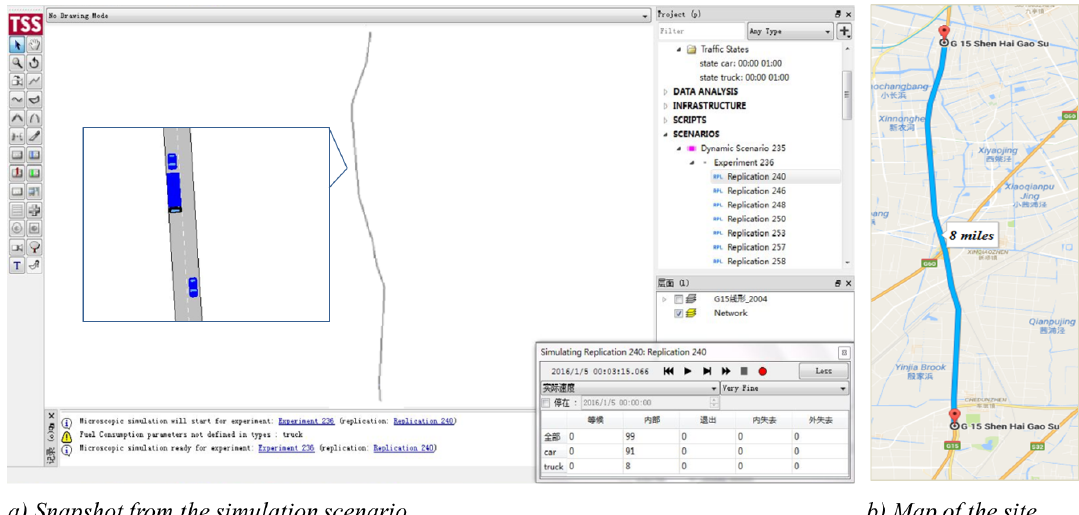
Fig 6. Aimsun interface of the simulated